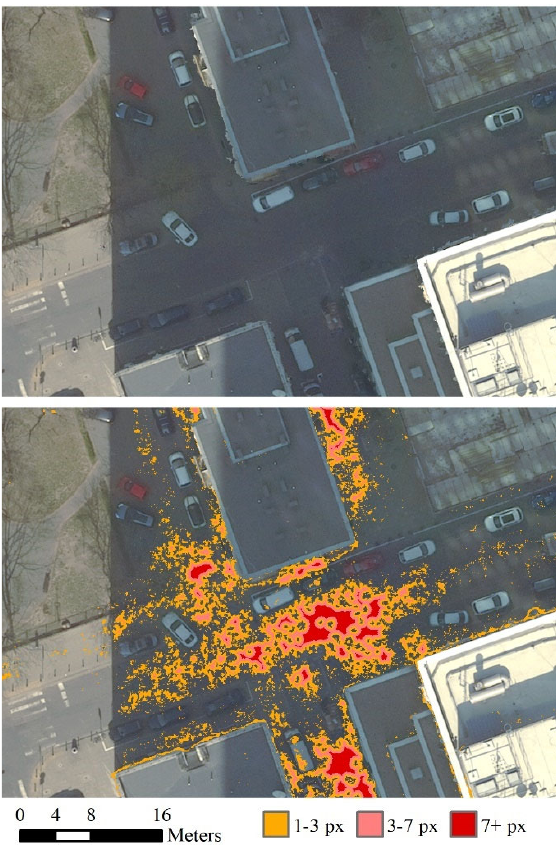
Figure 8. Part of the 4 th test area. Example of the large no data area between buildings where DSM interpolation did not affect the final true orthophoto quality.